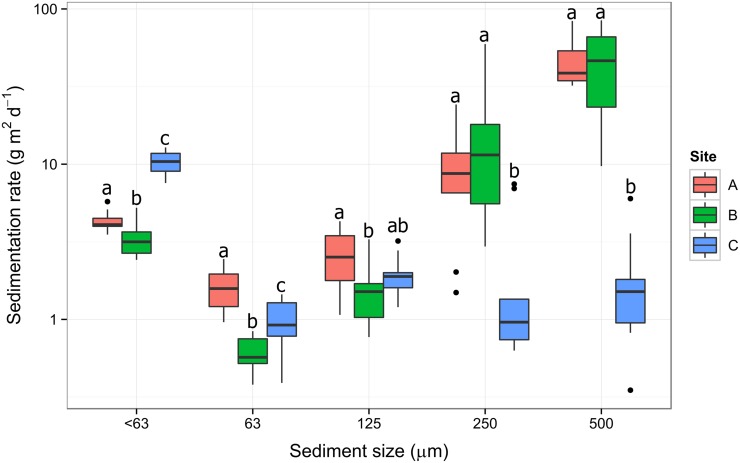
Box-plot of the sedimentation rates by size class over a 3-week period (22 March to 14 April 2014) at three sites along the Mangatainoka River.The y-axis scale is in a log10 scale to aid visualisation. Solid black line shows median, box shows 1st and 3rd quartiles, whiskers extend to the last data point within 1.5 times the inter-quartile range (n = 9). The letters above the boxes represent the results of Tukey pair wise comparisons.